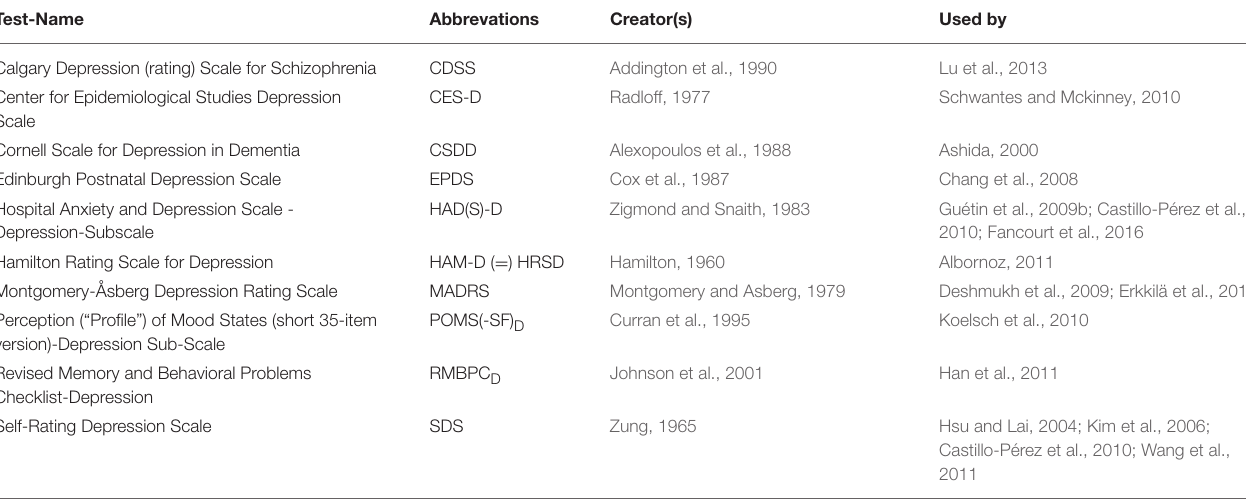
TABLE 4 | Additional tests, conducted by researchers within our article selection for investigating changes in depression.